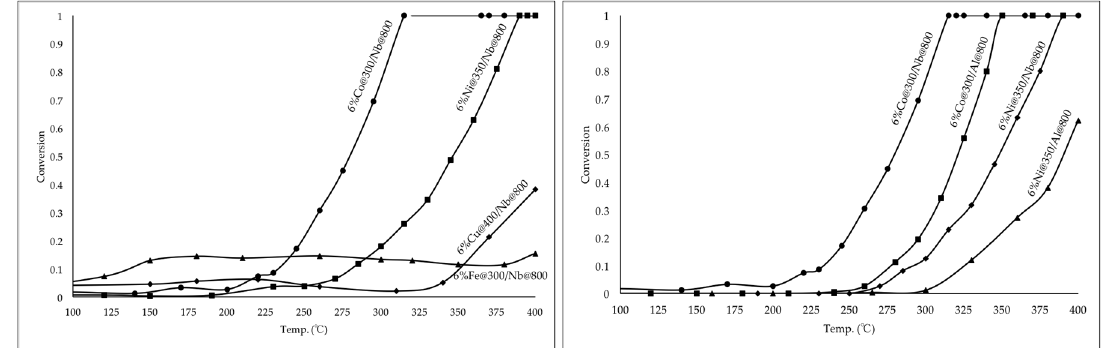
Figure 8. Different metal oxides (6%) on Nb@800 for propane oxidation (left); 6% Co 3 O 4 and 6% NiO on different carriers for propane oxidation (right). The iron catalysts were calcined at 300°C, impregnated nickel catalysts were calcined at 350°C, and impregnated copper catalysts were calcined at 400°C. C 3 H 8 0.1 vol %, O 2 18.9 vol %, N 2 81 vol %. Catalyst volume: 0.1 mL; GHSV: 64,800 (h − 1 ).